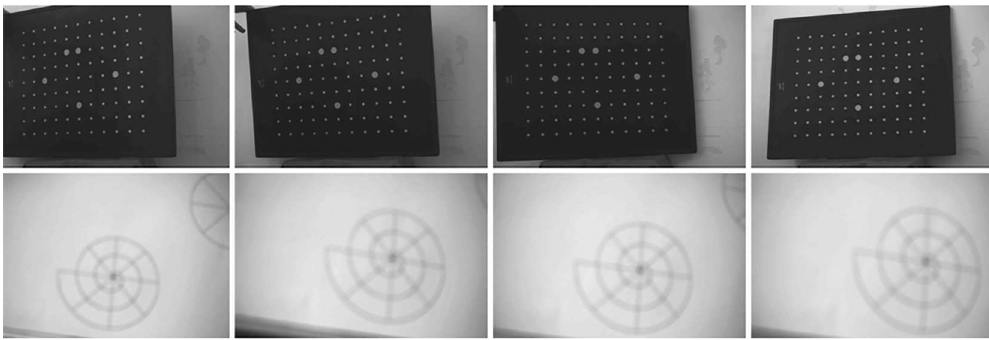
Fig 11. Real Pictures—the accurate calibration board is at the top, the polar coordinates calibration board is at the bottom.